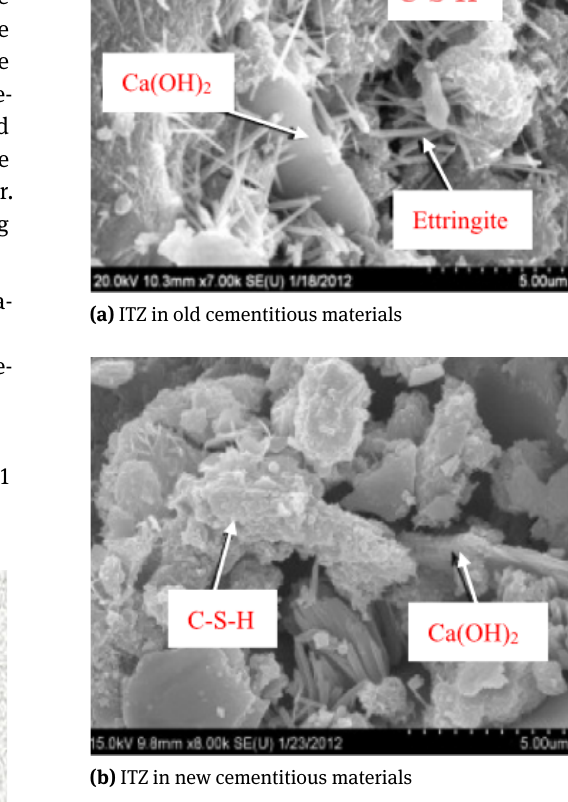
Figure 2: Difference in thickness between new and old ITZ [29]